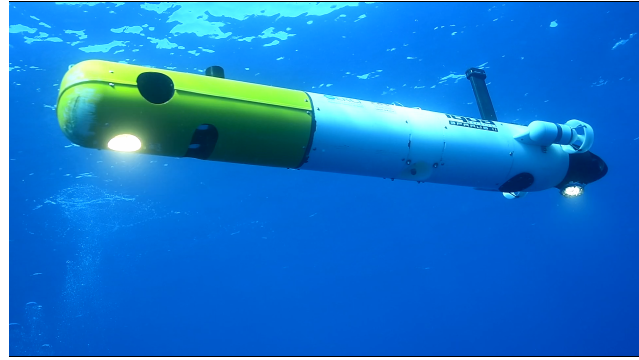
Figure 1. ALICE AUV during sea experiments in the Mediterranean